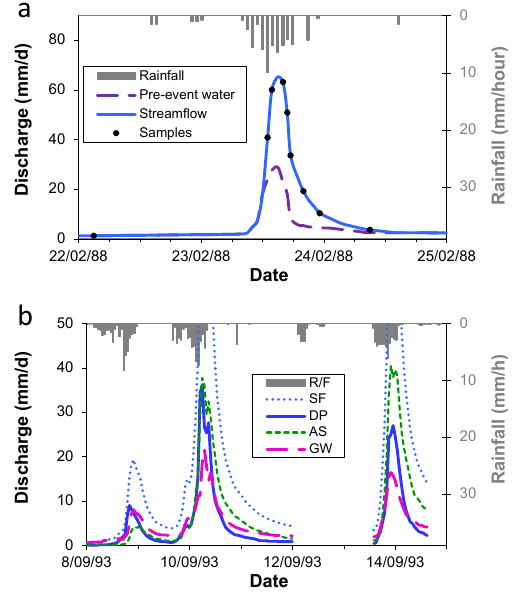
Figure 2. Tracer hydrograph separation results. (a) Event–pre-event water separation from catchment GH1, Glendhu, New Zealand, using deuterium (replotted from Bonell et al., 1990). (b) Three- component separation from Haute-Mentue research catchment, Switzerland, using silica and calcium (replotted from Iorgulescu et al., 2005). R/F is rainfall, SF is streamflow and the flow components are DP – direct precipitation, AS – acid soil and GW –